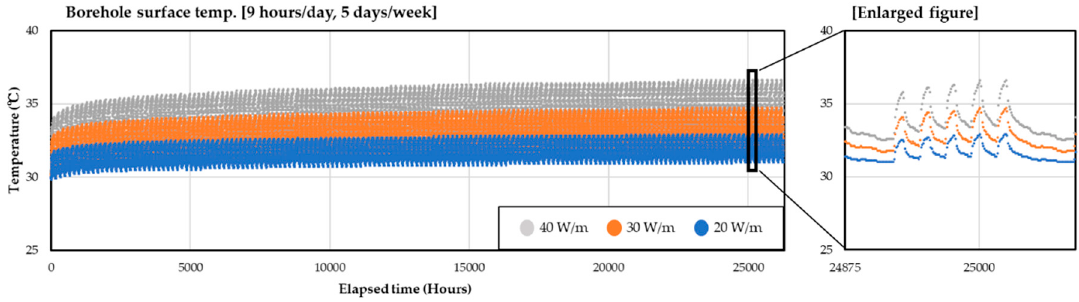
Figure 8. The three-year simulation of the BHE surface average temperature.